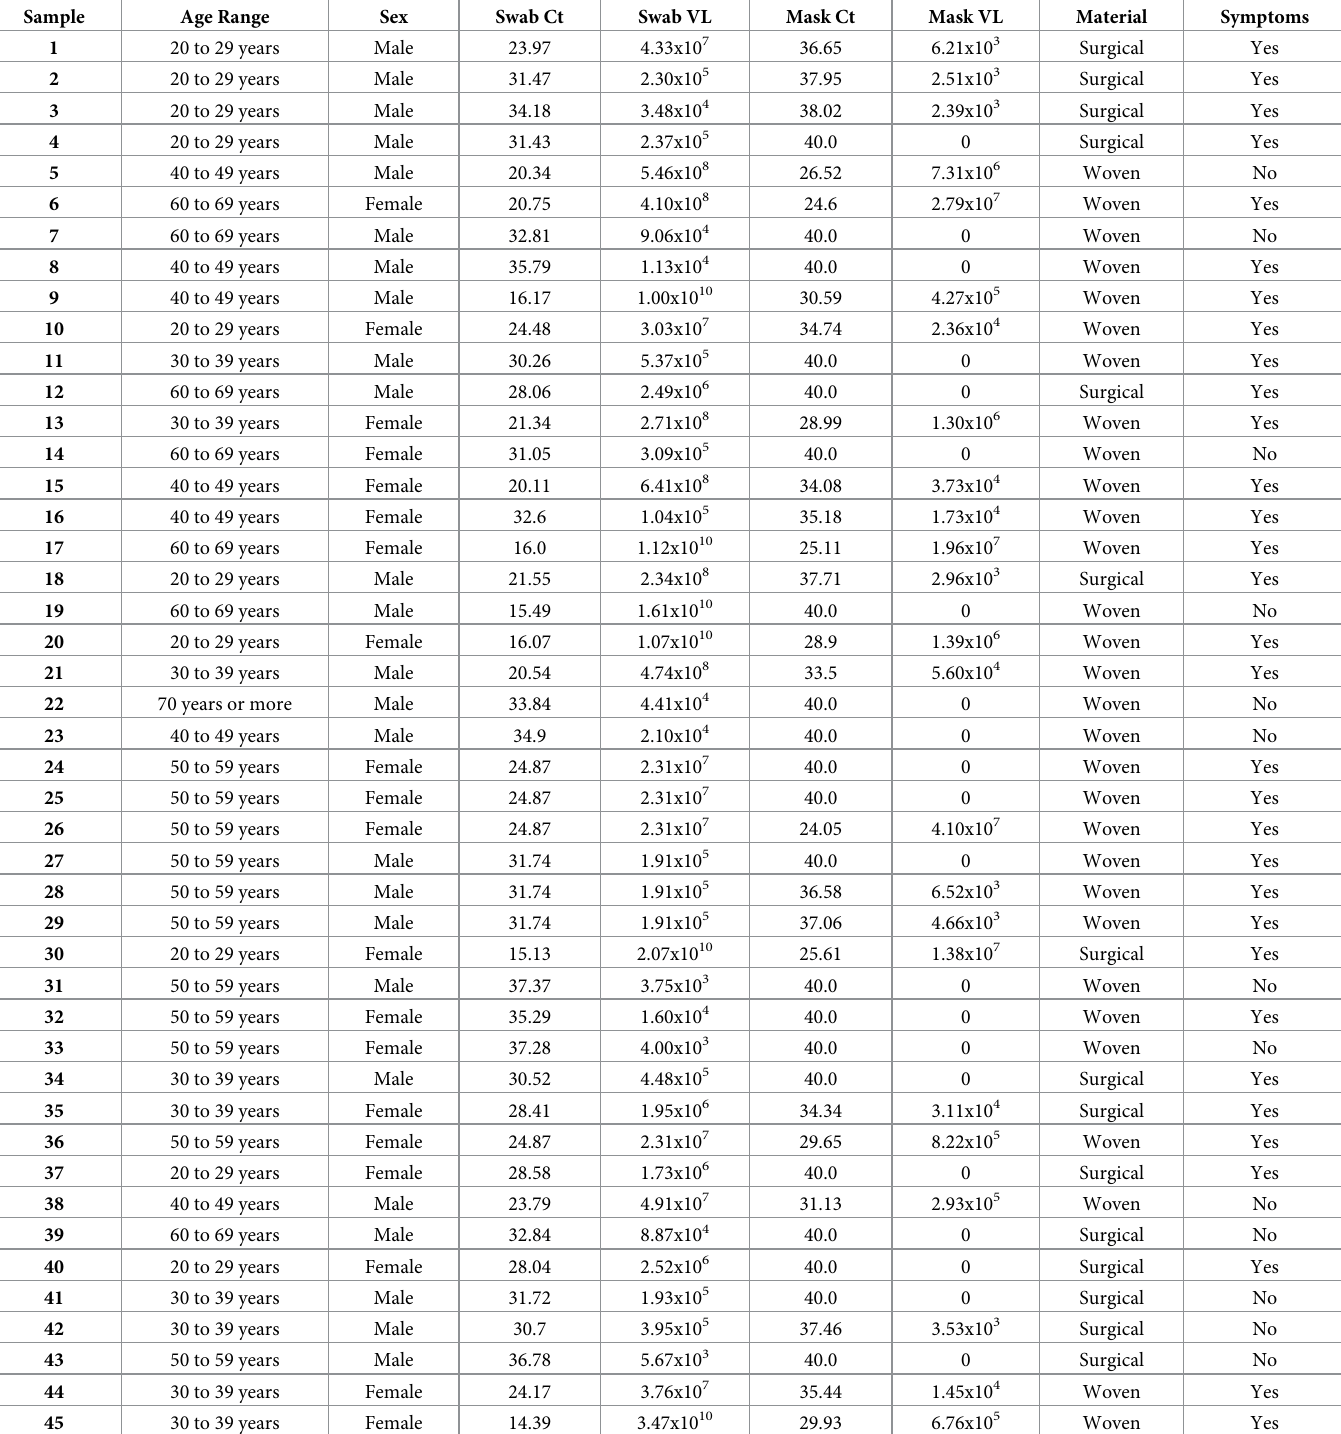
Table 1. Epidemiological characteristics of patients infected with SARS–CoV–2 in the present study.